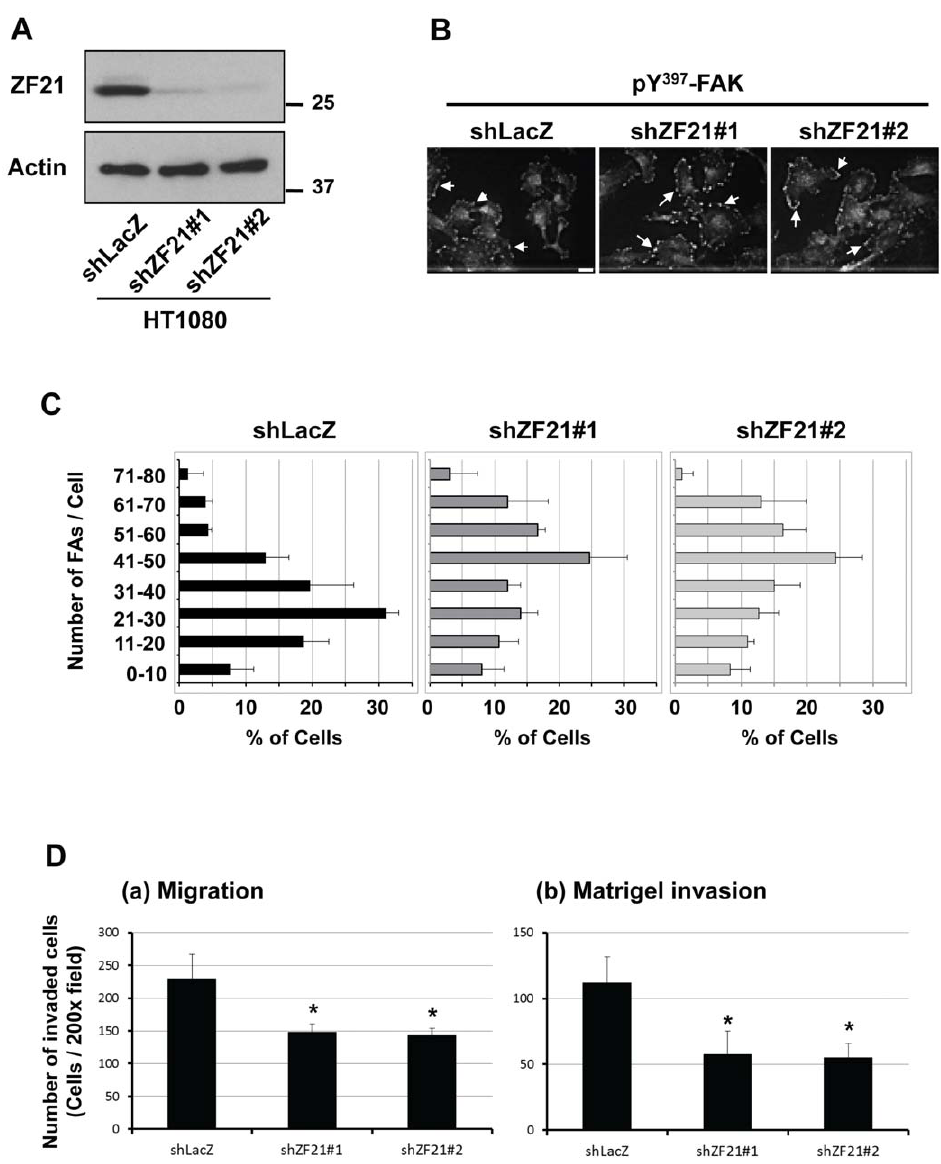
Figure 1. ZF21-knockdown increases the number of FAs and reduces the invasive activity of HT1080 cells. A. Expression of ZF21 in HT1080 cells was knocked down using either of two shRNA sequences targeting ZF21 mRNA (shZF21 # 1 and # 2). Endogenous ZF21 was detected by Western blot analysis by using a polyclonal anti-ZF21 antibody. B. The cells expressing shLacZ (top) or shZF21 # 1 and # 2 (middle and bottom) were seeded onto glass coverslips. After 48 h, FAK phosphorylated at Tyr 397 (pY 397 -FAK) was visualized with a specific antibody. Scale bar, 10 m m. C. Quantitative analysis of the number of pY 397 -FAK positive punctate signals. The number of pY 397 -FAK positive punctate singals was counted in 100 cells. The experiment was independently repeated three times. D. The cells expressing shLacZ or shZF21 # 1 and # 2 were subjected to a migration (a) and a matrigel invasion assay (b) using a transwell chamber equipped with filters coated with fibronectin or matrigel. As an attractant, fetal bovine serum was added in lower chamber. Error bars indicate the means 6 S.D. (n=3).*, p , 0.05 (Student’s t